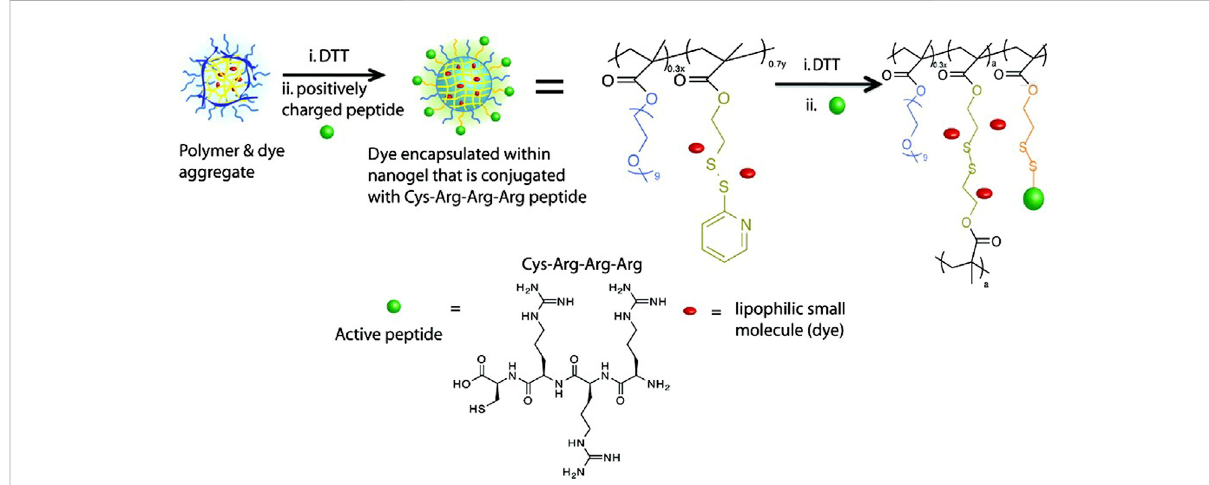
FIGURE 5 Structures of the nanogel ’ s polymer precursor and tri-arginine peptide. Reproduced with permission from Ref. (González-Toro et al., 2012).